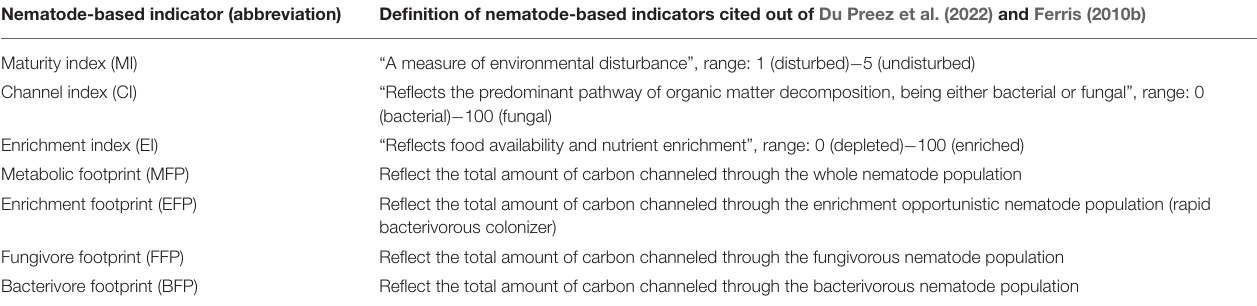
TABLE 1 | Nematode-based indicators used in the study and their ecological meaning. Nematode-based indicator